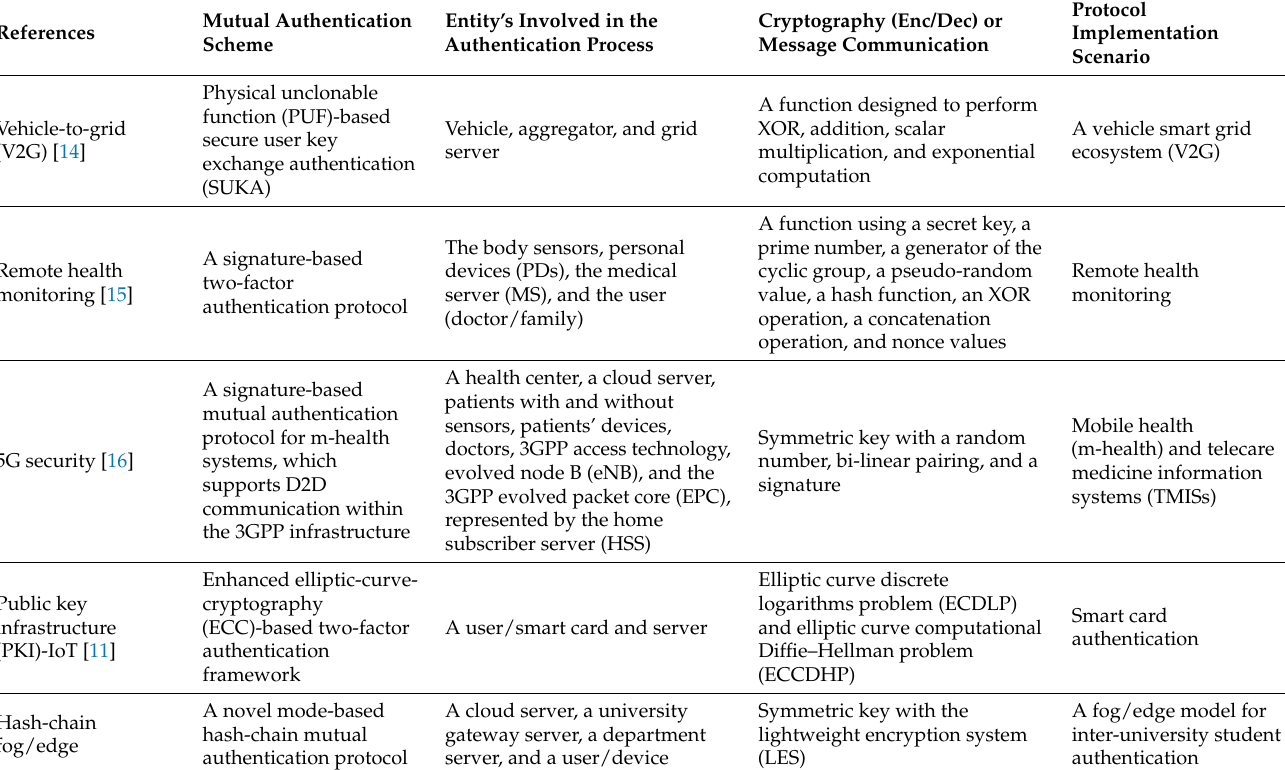
Table 1. Comparison with the recent